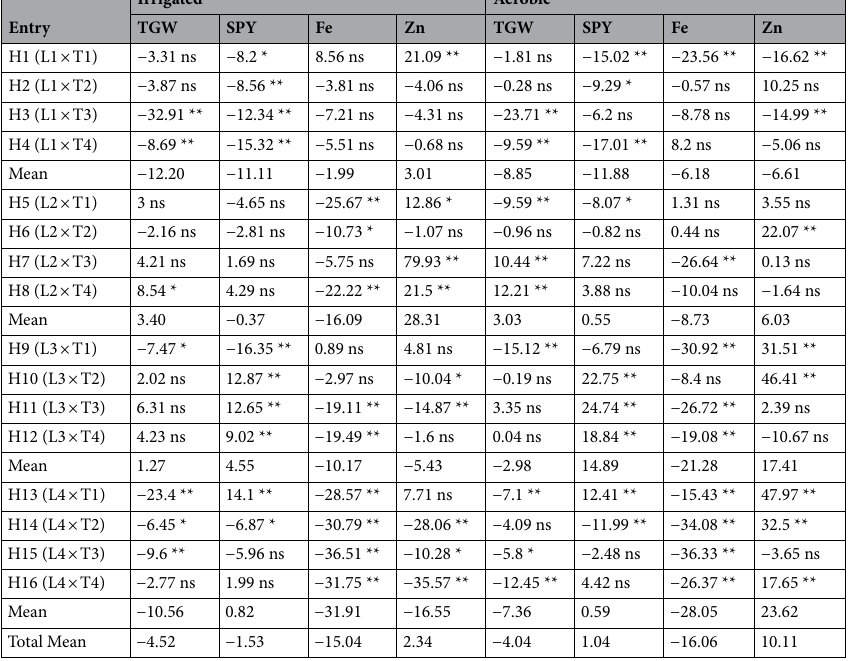
Table 6. Estimation of best-parent heterosis (BPH) for yield components (TGW and SPY), grain Fe and Zn concentration of crosses (Hybrids) in irrigated and aerobic method. *P < 0.05; **P < 0.01; ns—not